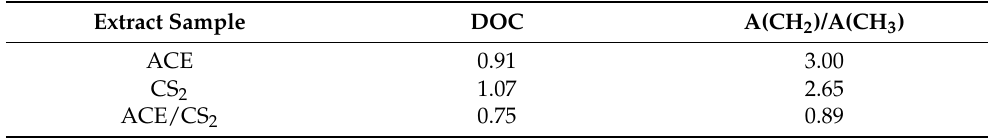
Table 6. Structural parameters of the three extracts.